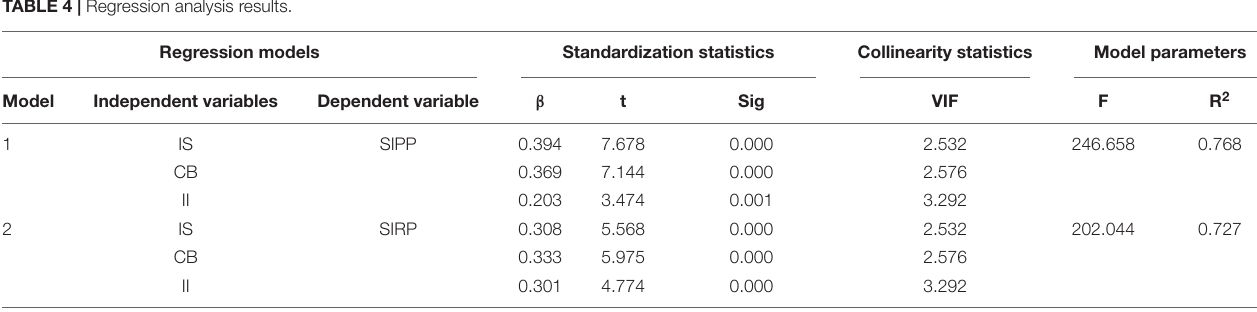
TABLE 4 | Regression analysis results.